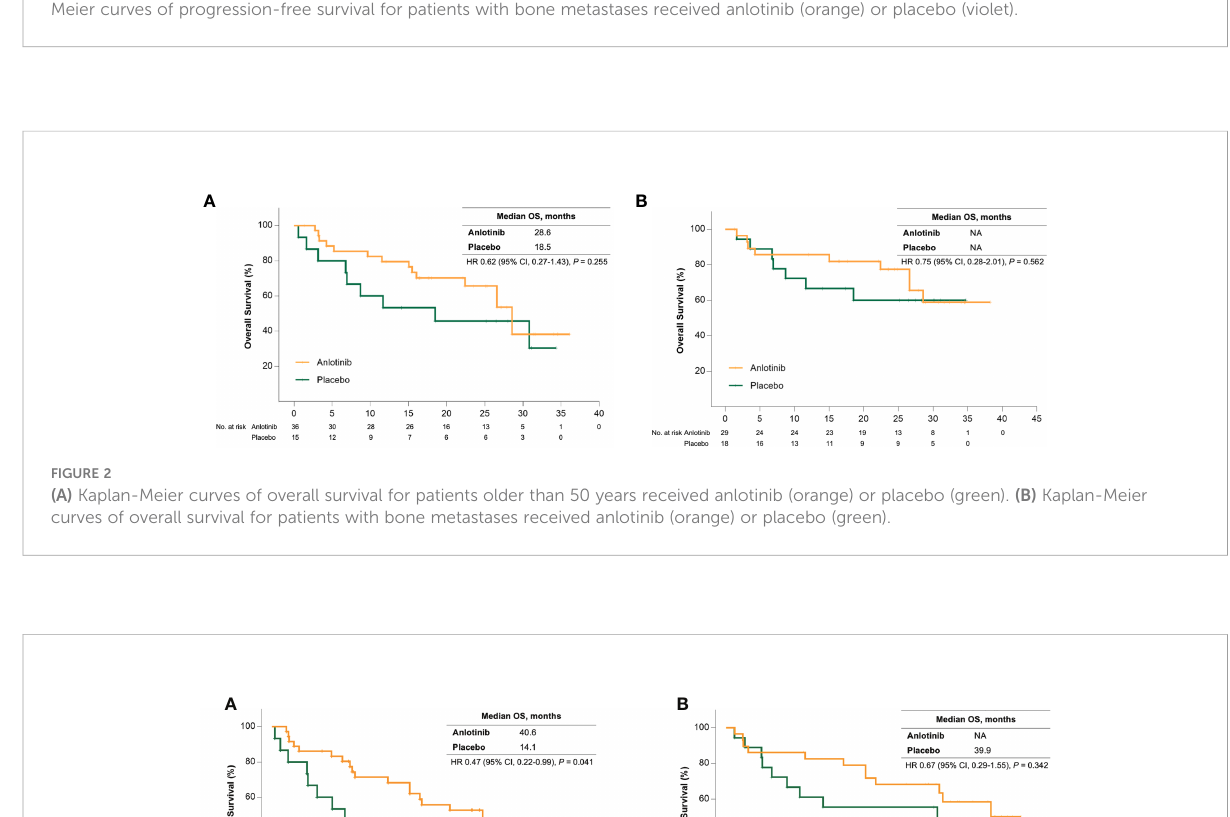
[95% CI, 0.29 – 1.55], P = 0.342) (Figure 3B).